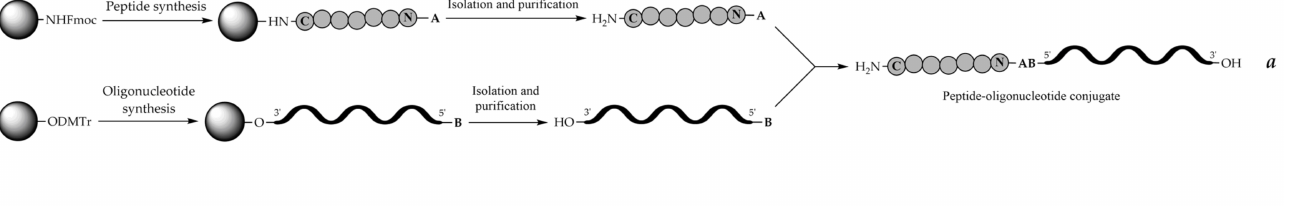
Figure 8. The main schemes of the post-synthetic conjugation approach: ( a ) conjugation in solution and ( b ) fragment conjugation on the solid